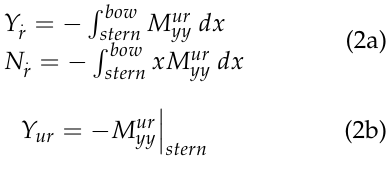
Figure 2. Bare hull—strip theory sectional forces.